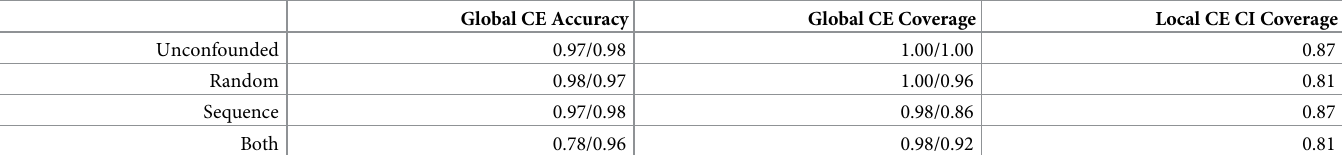
Table 1. DeepMR estimates causal effects (CE) accurately with high coverage. Accuracy is R 2 . Local corresponds to CEs for individual regions, global for the meta-analy- sis mean. For global CE accuracy and coverage the first value comes from using MR-Egger and the second from the baseline MR